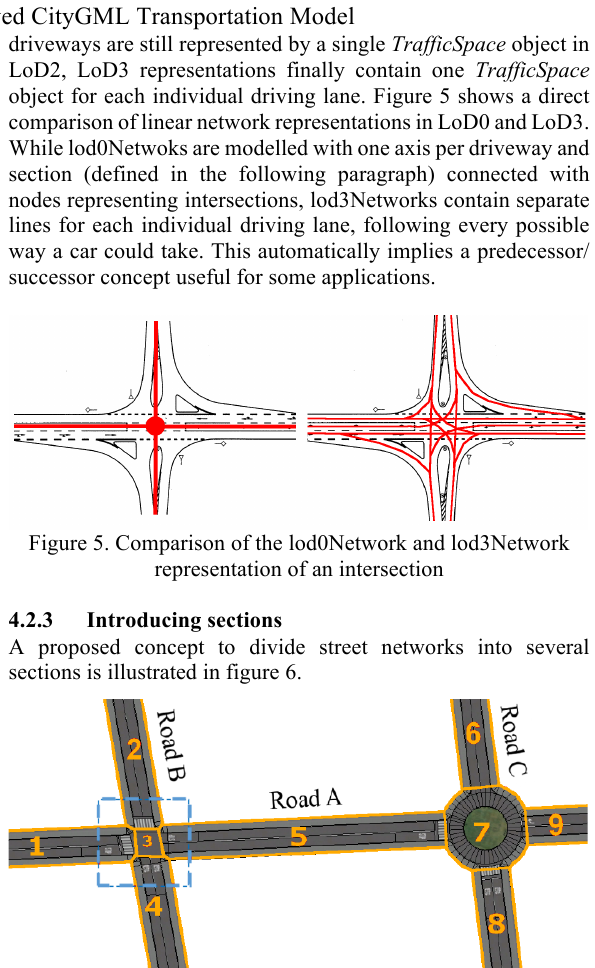
Figure 2. UML diagram of the improved CityGML Transportation Model